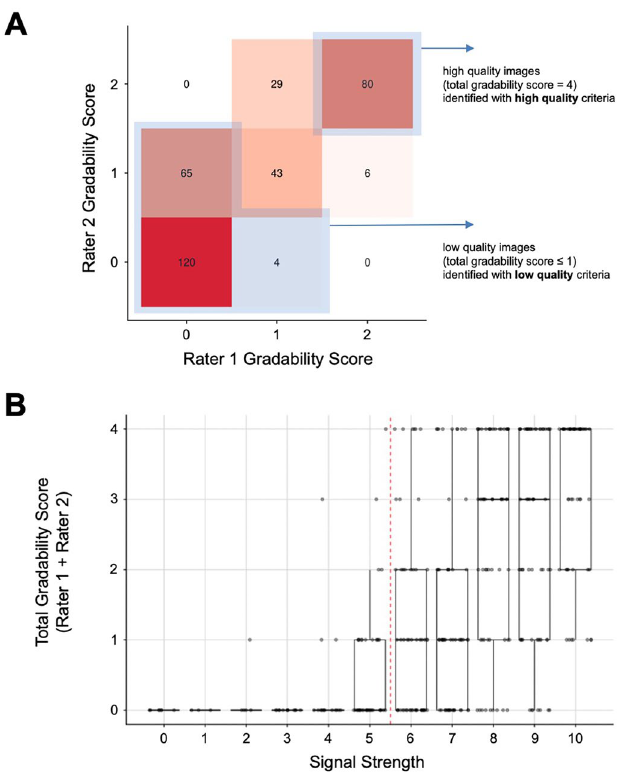
Figure 2. Plot showing gradability scores for each independent grader and comparison with machine-reported signal strength. ( A ) The sum of gradability scores was used to create a total gradability score. Images with total gradability score of 4 were designated as high quality, and those with total gradability score of less than or equal to 1 were designated as low quality. ( B ) Signal strength is correlated with manual gradability score, but images of high signal strength may still be of low quality. Red dashed line indicates manufacturer recommended signal strength based quality cutoff (signal strength ≥